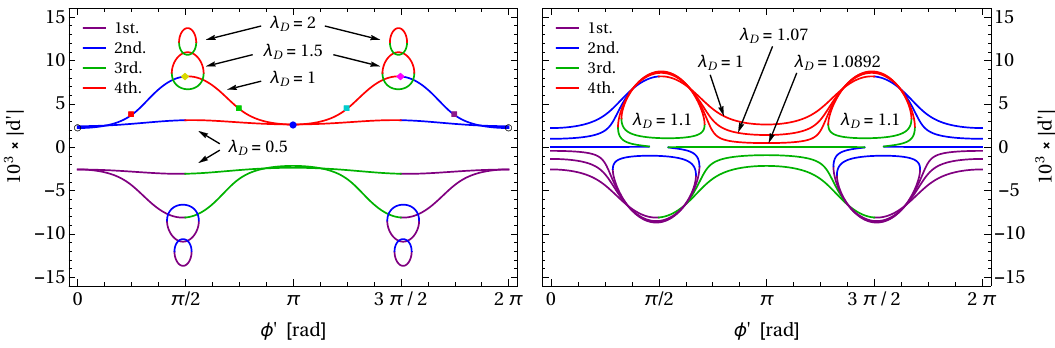
Figure 3 . (Color online) The four solutions for j d 0 j of eq. (3.43) at di(cid:11)erent values of (cid:30) 0 = arg( d 0 ) is shown. The dependency changes with (cid:21) D : a coarse change of (cid:21) D is shown on the left, and a (cid:12)ner study of is shown on the right. M R (cid:24) m 4 = 10 10 GeV is (cid:12)xed. The normal hierarchy is assumed. The parameters of the Higgs sector are taken from the benchmark point B1 [37]: m H = 300 GeV, m A = 441 GeV, and (cid:12) (cid:0) (cid:11) = 0 : 522 (cid:25) (cid:17) (cid:0) 0 : 478 (cid:25) . The negative solutions are not physical, but give a much better impression about the general behavior of the